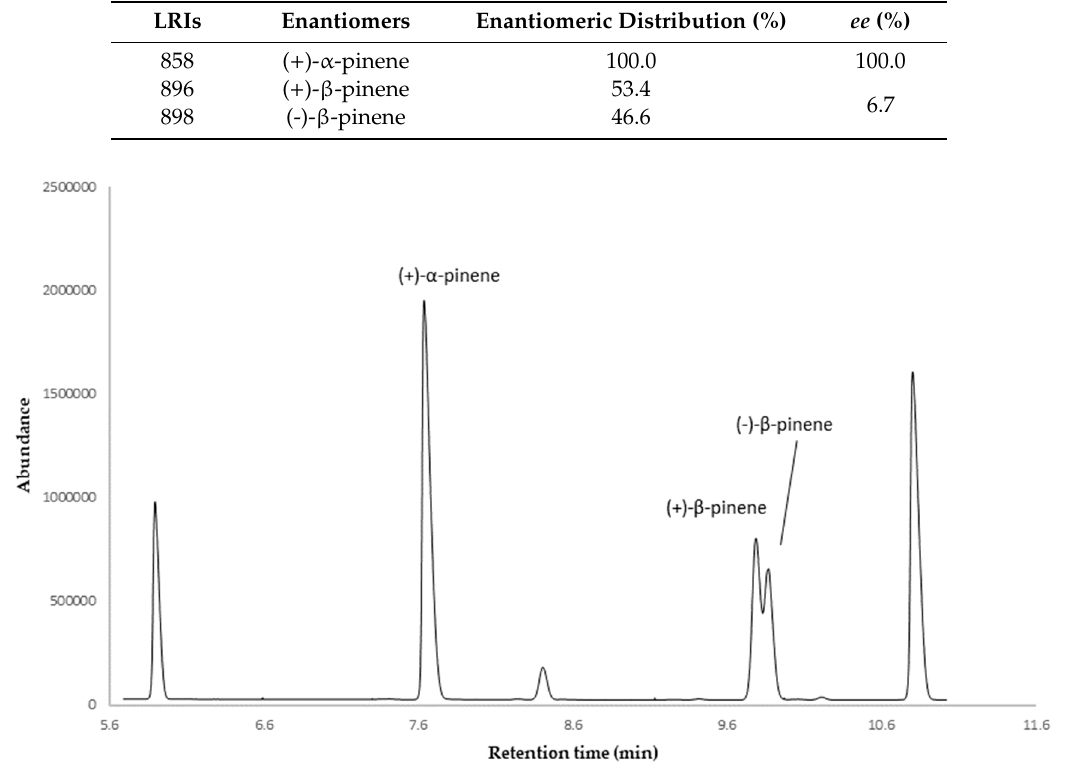
Figure 3. Enantioselective analysis of essential oil (EO) of S. echinata on diacethyl terbutylsilyl- β - cyclodextrin column.